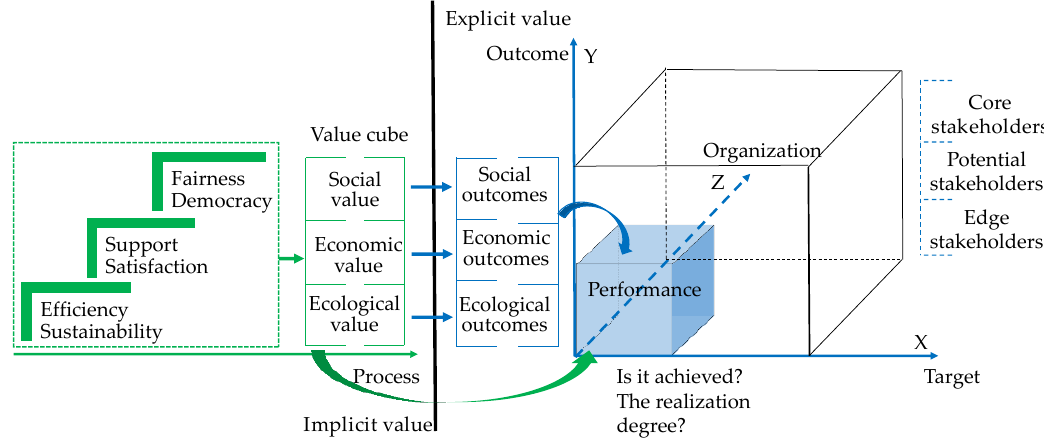
Figure 4. Framework for evaluating performance.